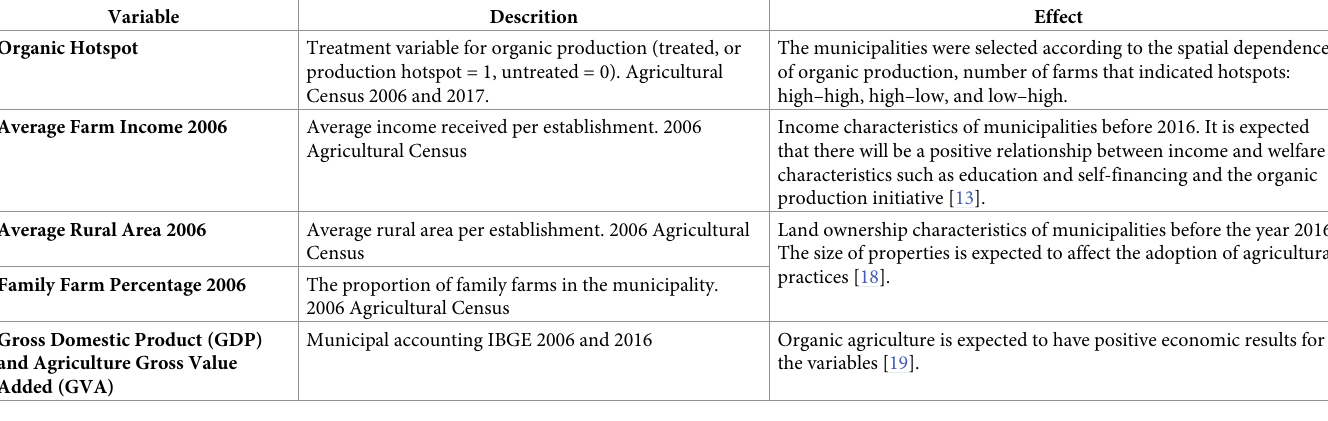
Table 2. Variables selected to assess the economic effect of organic production.